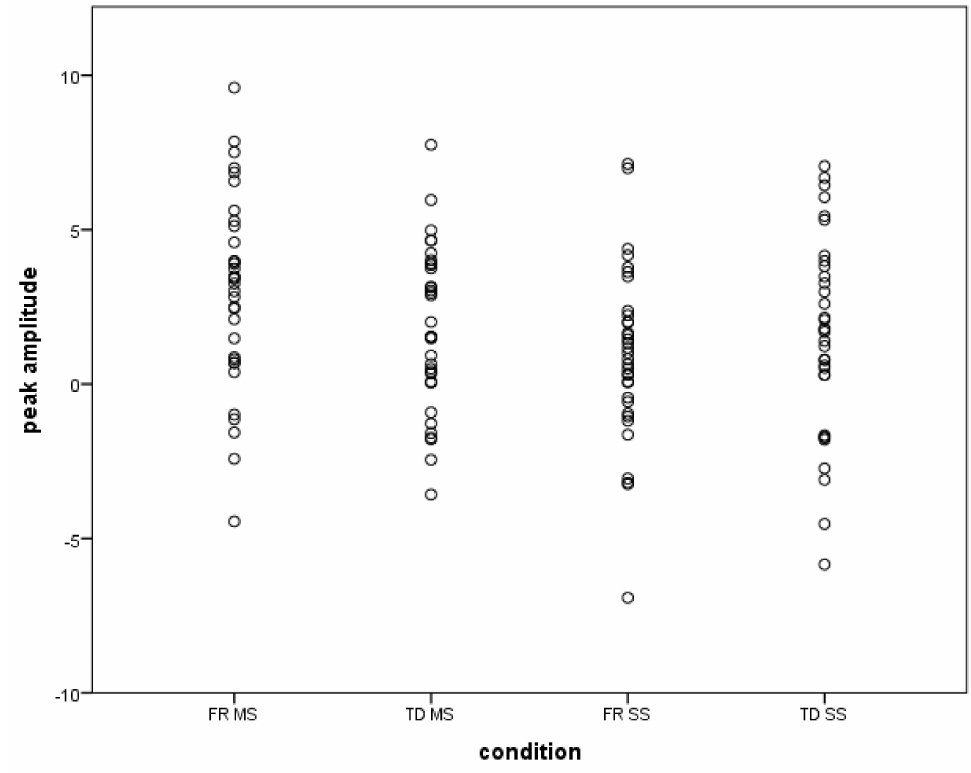
Figure 3. MMR peak amplitude at F3 of individual participants in the multiple- and single-speaker conditions. FR = familial risk group, TD = typically developing group, MS = multiple-speaker condition, and SS = single-speaker condition. Each circle represents an individual